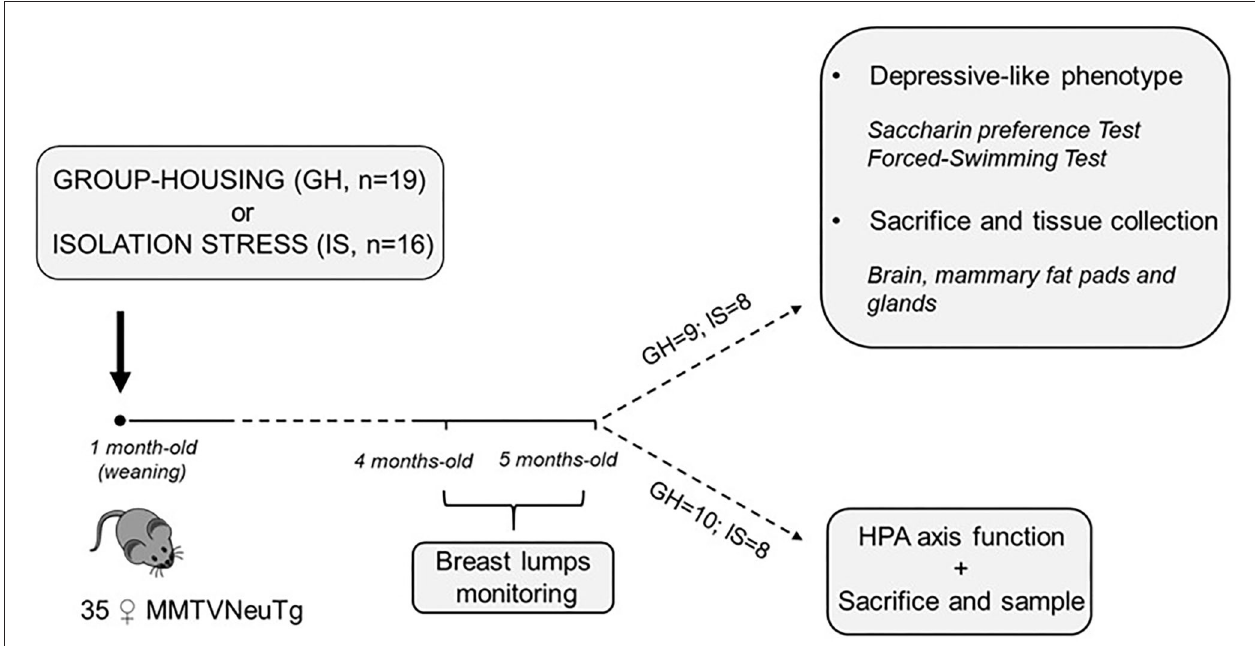
FIGURE 1 | Timeline of the experimental